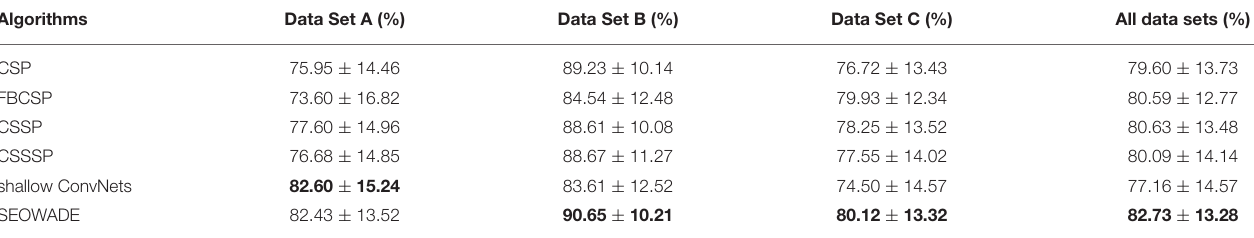
The entries highlighted in boldface indicate the best performance among the competing